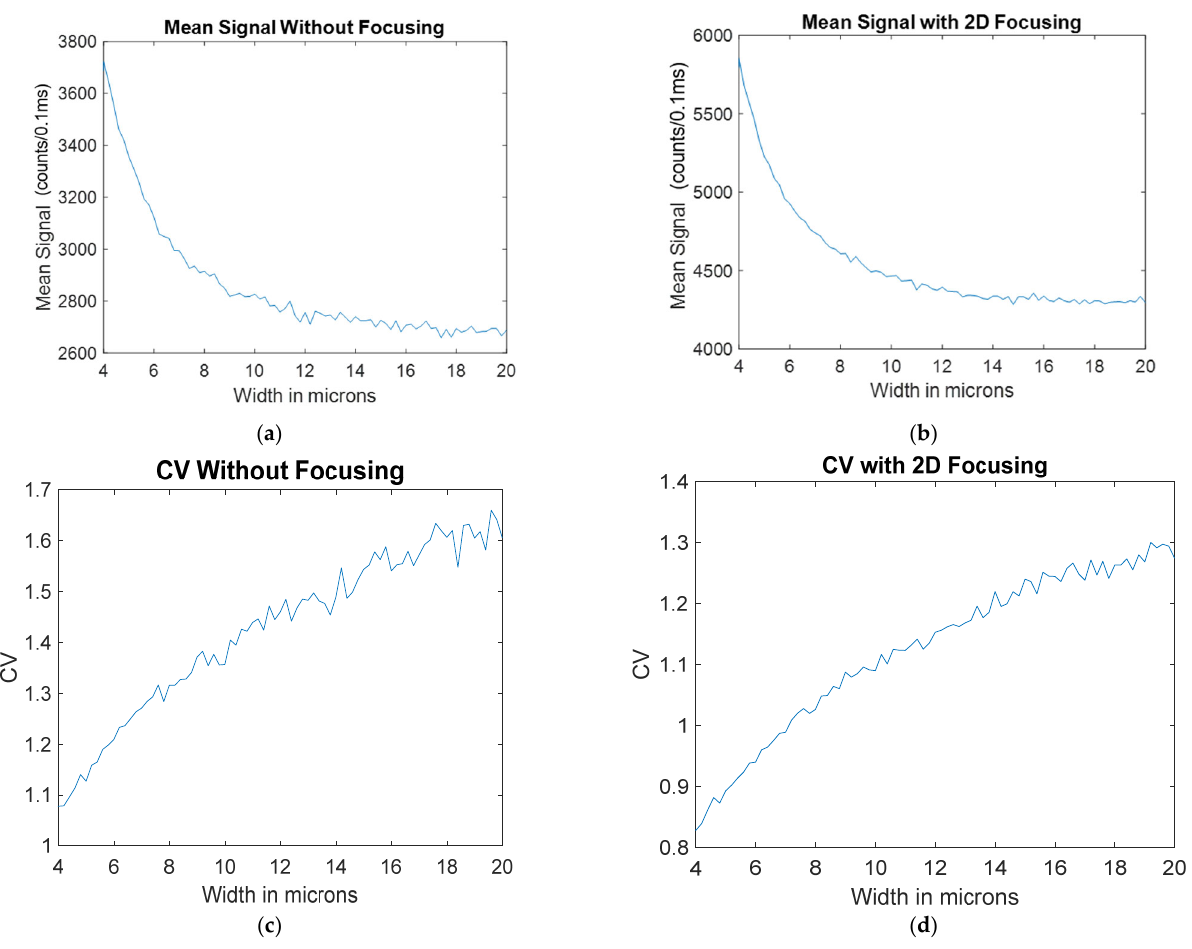
Figure 11. The result of increasing the spot size for a biosensor illuminated with a spot laser including the mean signal as a function of width for: ( a ) no focusing; ( b ) 2D hydrodynamic focusing. The increase in CV as a function of width for: ( c ) no focusing; ( d ) 2D hydrodynamic focusing. As seen in Figure 11, having a narrow spot size for both the focused and unfocused cases results in a higher mean and lower CV than the line laser and windowed